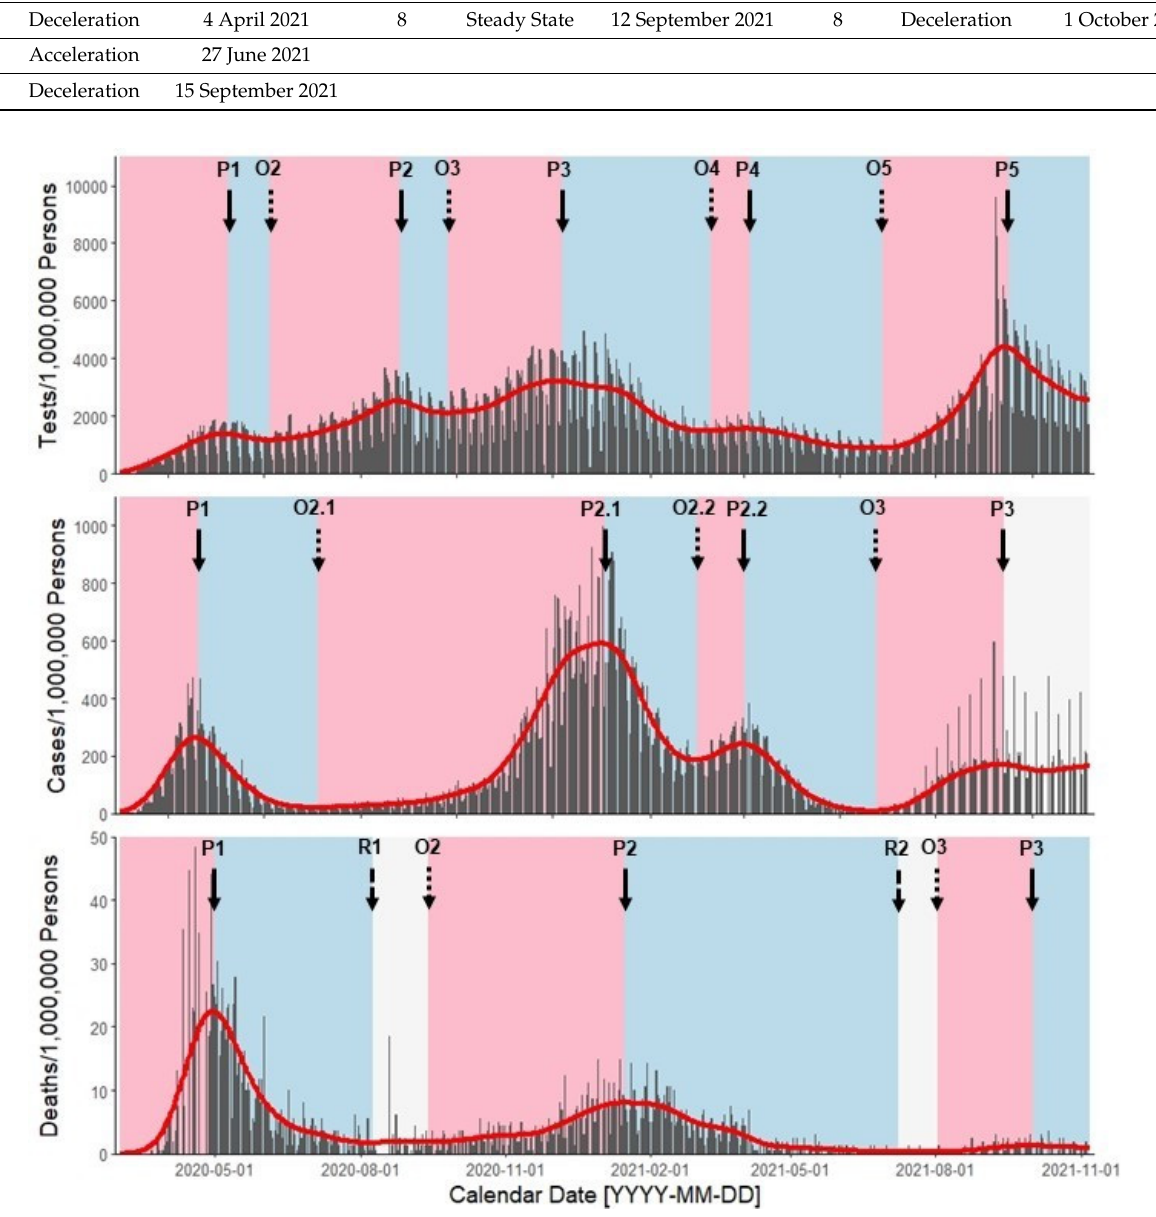
Figure 1. Multi-panel, shared-axis time series plots of MDPH-reported Massachusetts statewide tests (top panel) and JHU-reported Middlesex County cases and deaths (middle and bottom panels, respectively) from 2 March 2020 through 7 November 2021. Within each plot, we provide estimated rates (grey bars) from reported data and 21-day average smoothers (red lines) estimated using Kolmogorov-Zurbenko adaptive filters. Background colors depict acceleration periods (pink), deceleration periods (blue), and steady-state periods (grey) defined independently for each health outcome. We embedded text and arrows at the top of each plot to signify the onset timing (O1–O5, short dashed arrow), peak timing (P1–P5, solid arrow), and resolution timing (R1–R2, long dashed arrow) across outbreak waves. We report rates as tests, cases, and deaths per 1,000,000 persons.